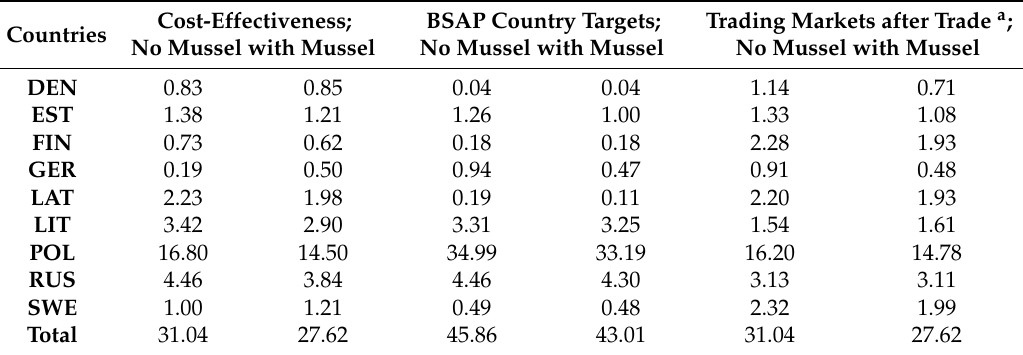
Table 1. Allocation of costs between countries for reaching BSAP overall nitrogen and phosphorus targets under different international policy regimes, billion